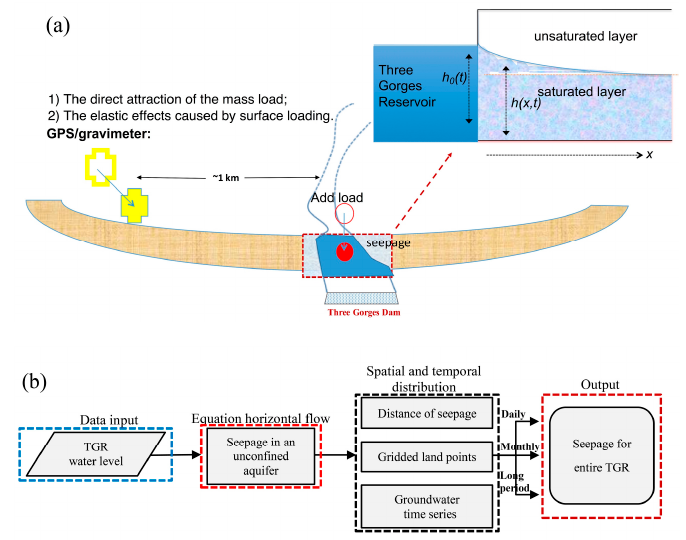
Figure 4. ( a ) Diagram showing horizontal flow and response in terms of gravity and deformations during the TGR water filling. ( b ) Flowchart for the leakage estimation using horizontal flow modeling for the entire TGR.